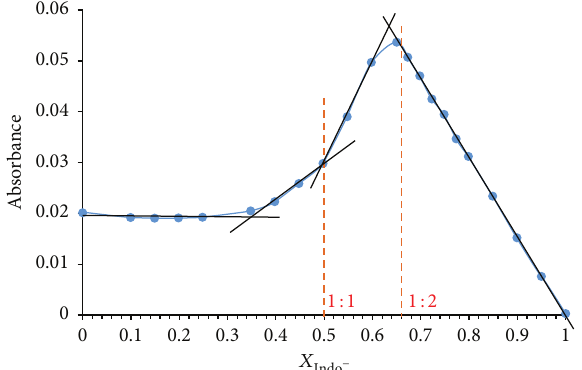
Figure 8: The 𝑋 Indo − = 0.50 and 0.66 indicate the formation of CuIndo + and CuIndo 2 species.